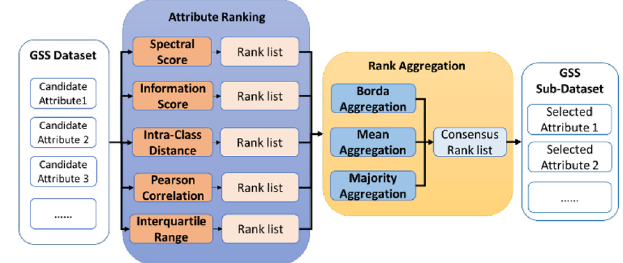
Figure 2. Flow diagram of attribute selection